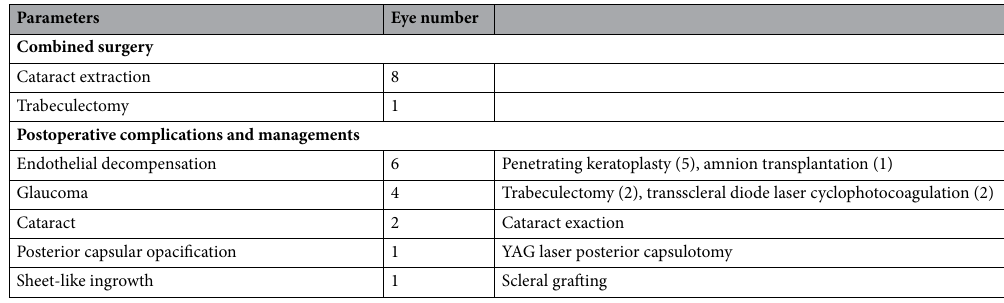
Table 1. Surgical procedures and postoperative characteristics of patients with secondary epithelial iris